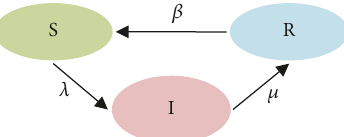
Figure 3: Health food safety scare behavior diffusion